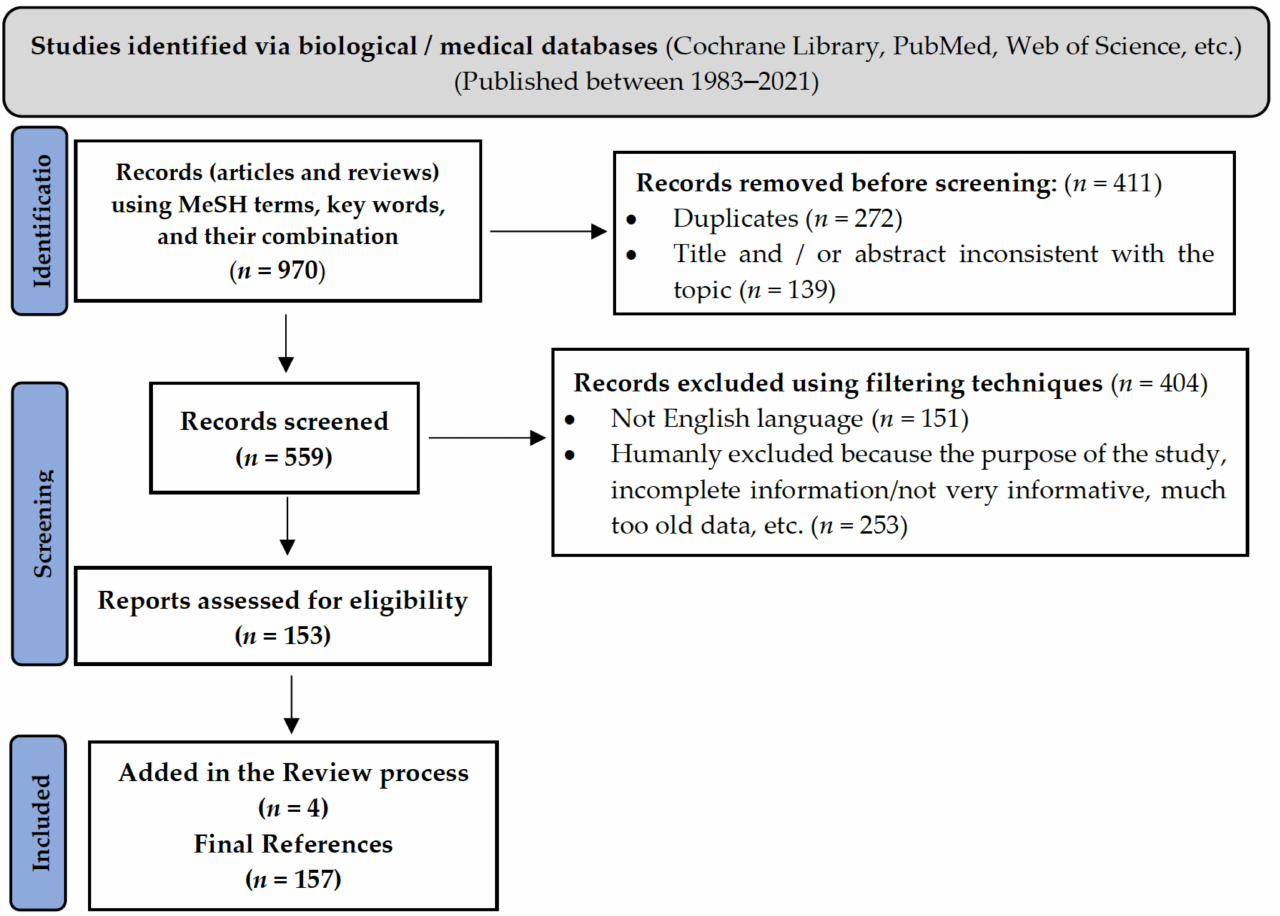
Figure 1. PRISMA flow-chart summarizing the criteria of selection of the literature. MeSH = Medical Subject